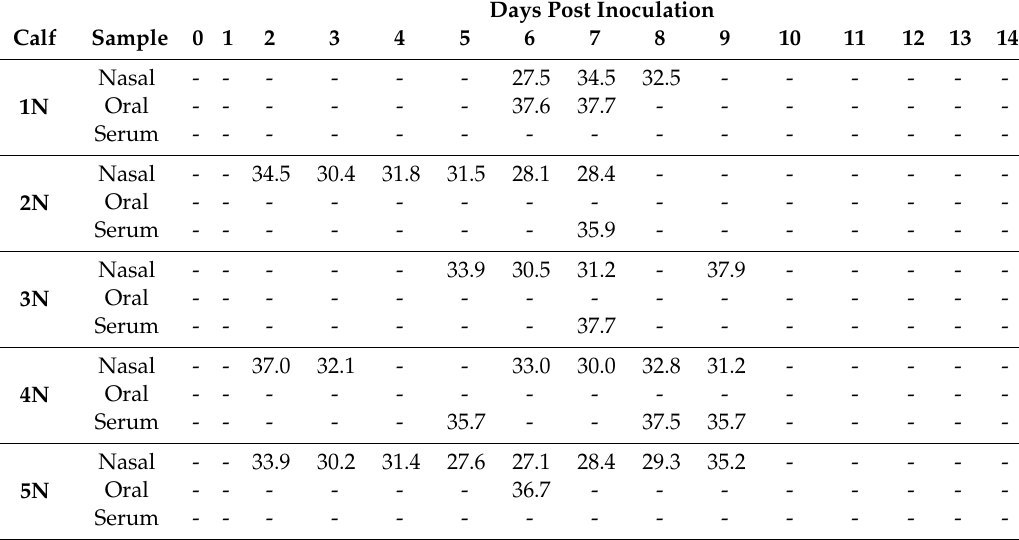
Table 3. Bungowannah virus qRT-PCR results from calves intranasally inoculated. Days Post